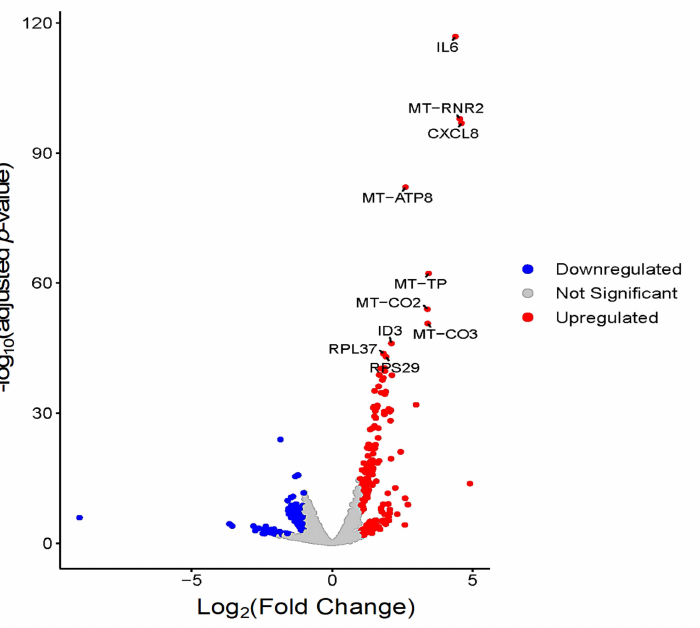
Figure 13. Volcano plot comparing the top 10 genes with the highest differences in expression between infected and control samples at 48 hpi. Upregulated (red) and downregulated (blue) genes are shown. p -values were plotted on the y -axis while log 2 FC values are plotted on the x -axis. Each dot in the plot represents one